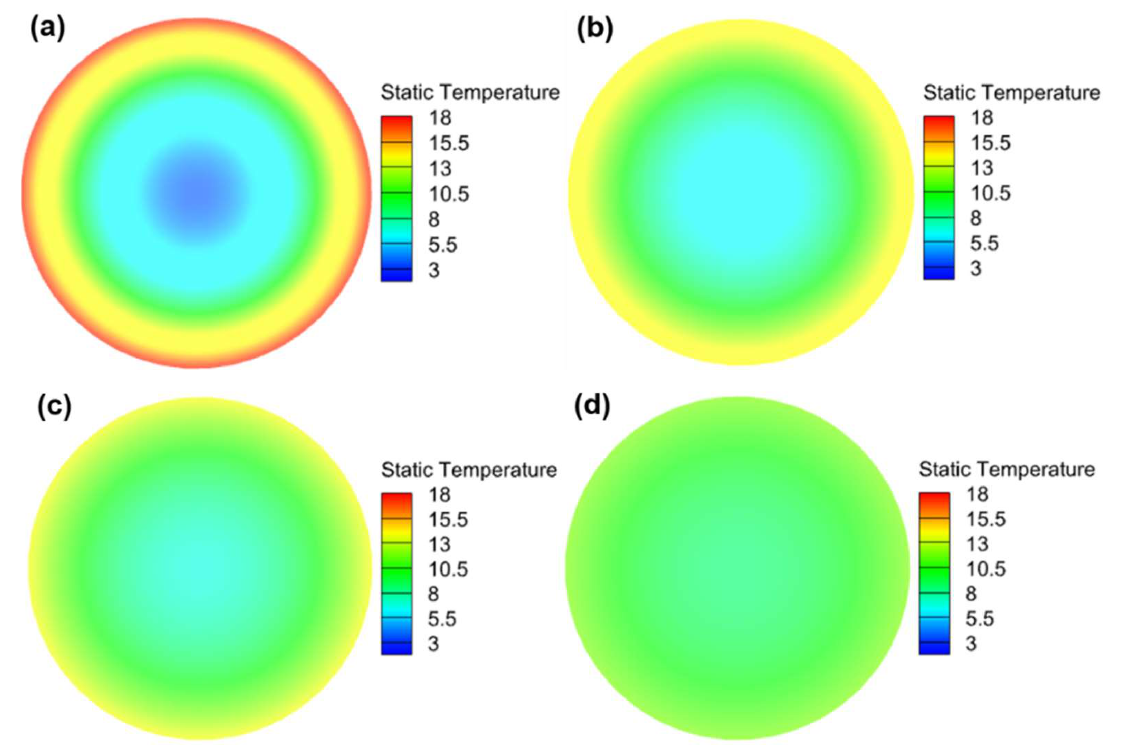
Figure 15. Temperature distribution in the radial direction inside the cell. Heating for ( a ) 30 s; ( b ) 60 s; ( c ) 90 s; ( d ) 180 s.